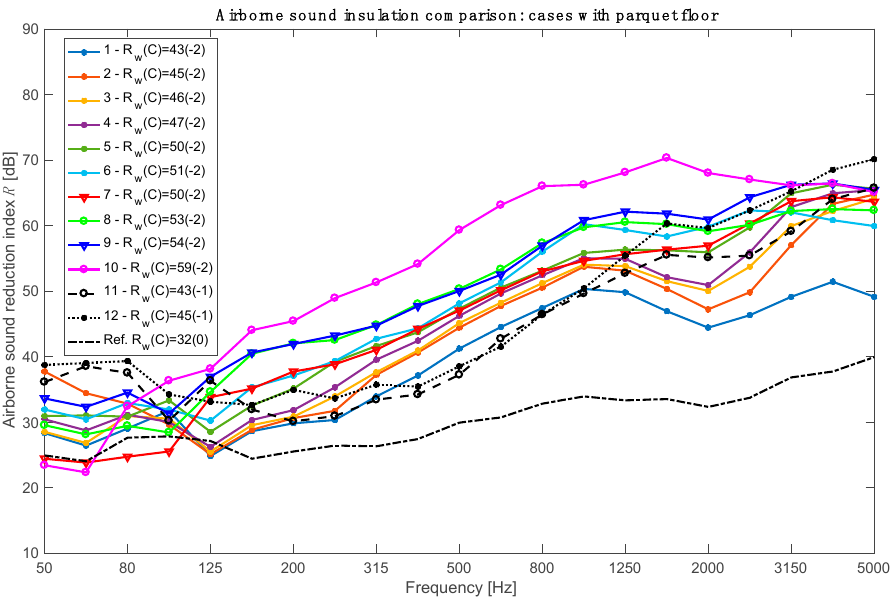
Figure 1. Airborne sound reduction index R curves of the test floors (laboratory measurements).